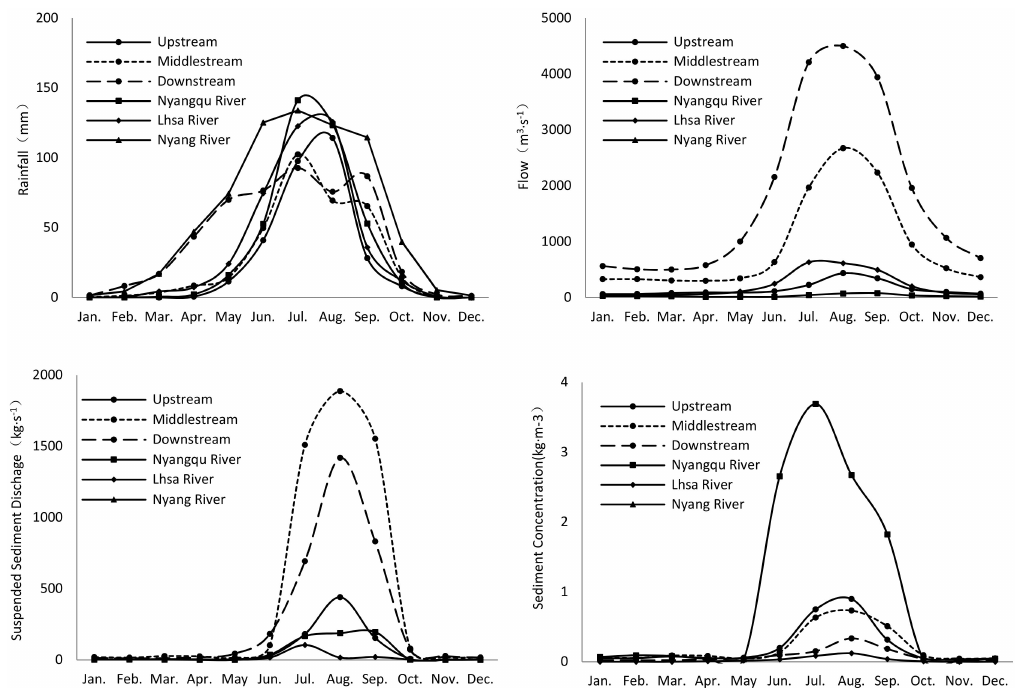
Figure 8. Hydrographic parameters in mainstream of the Yarlung Zangbo